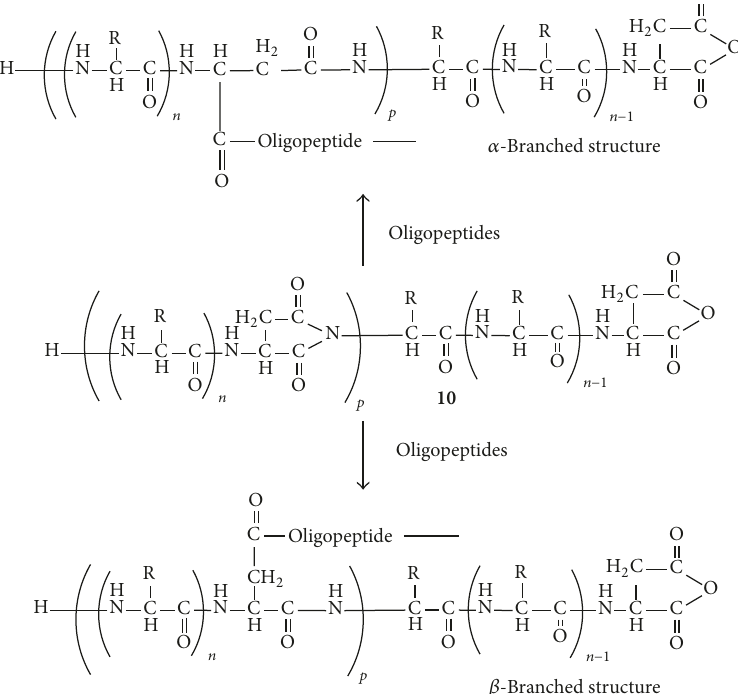
Figure 15: Postulated branched structures from Boc-peptides upon heating. 𝑛 = 1 for 5a–c ; 𝑛 = 2 for 5d . 𝑛 and 𝑝 : natural number ( 1, 2,3, . ..